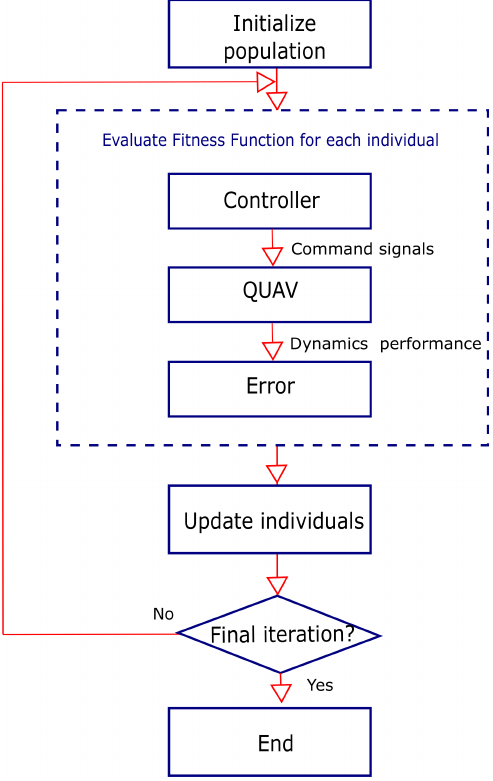
Figure 4. Flowchart: controller parameter tuning